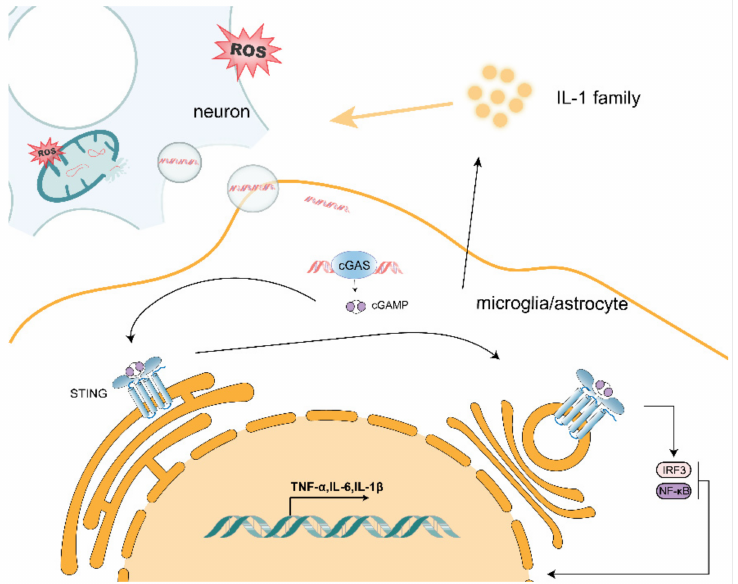
Figure 1. Release of mtDNA from neurons causes activation of the cGAS/STING pathway in neighboring microglia and astrocytes, leading to increased transcription of pro-inflammatory